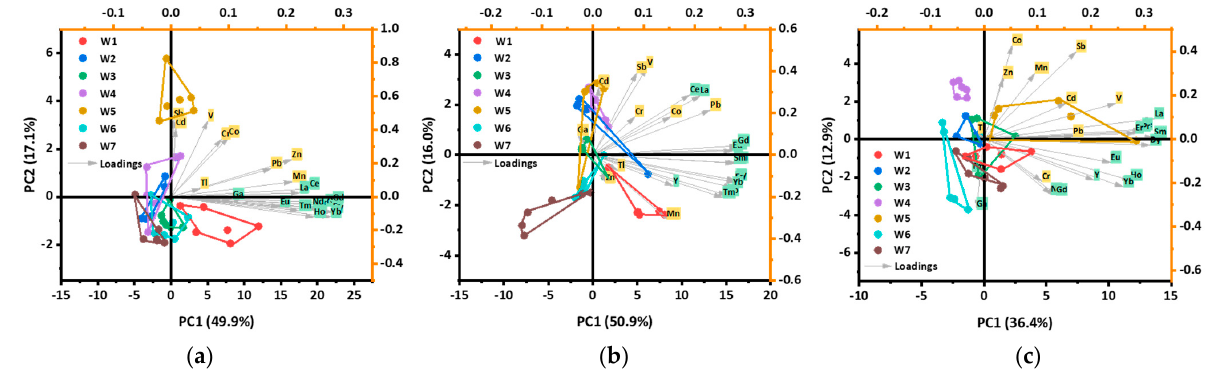
Figure 2. Principal component analysis for 23 elements in influent ( a ), sludge ( b ), and effluent ( c ) at 7 WWTPs. Arrows indicate 23 elements. Dots indicate WWTP: red—W1, blue—W2, green—W3, purple—W4, goldenrod—W5, cyan—W6, and brown—W7. Letters with a yellow background are heavy metals, whereas those with a green background are REEs.